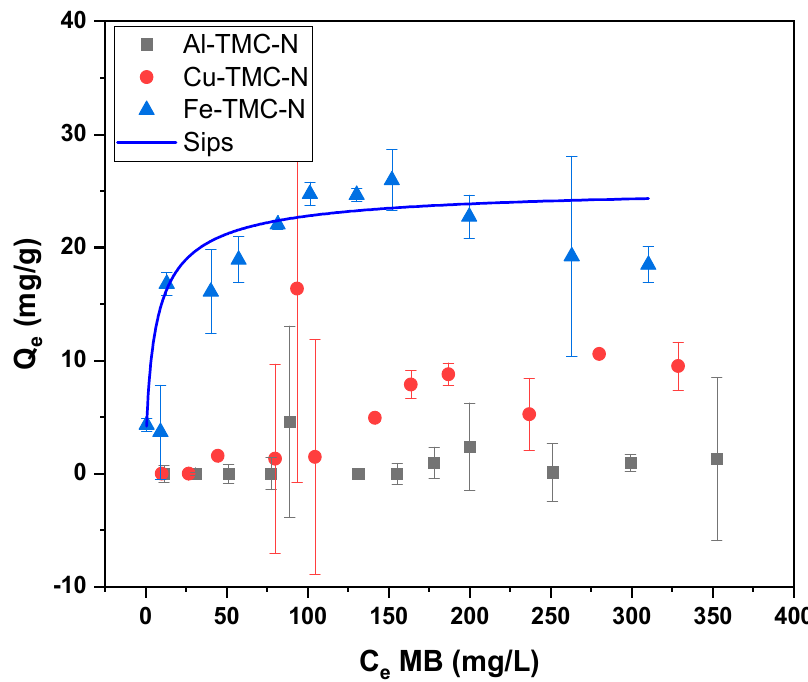
Figure 5. Equilibrium uptake profiles of MB onto three types of TMC materials, where only Fe-TMC-N was fitted by the Sips isotherm model (blue line) due to limited adsorption displayed by the other TMCs that contain Al(III) and Cu(II).